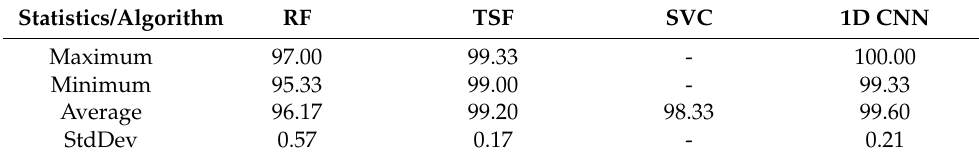
Table 6. Performance of different classification methods on publicly available dataset.